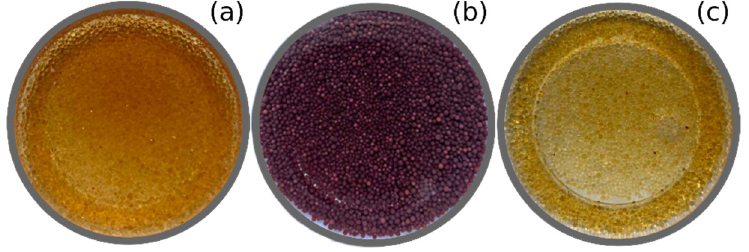
Figure 1. Appearance of the ion exchange resin: ( a ) KU 2-8 initial resin, ( b ) resin modified with hematite (model SIER), ( c ) purified model SIER. Table 1. Characteristics of the model SIER per 1 g of dry resin.